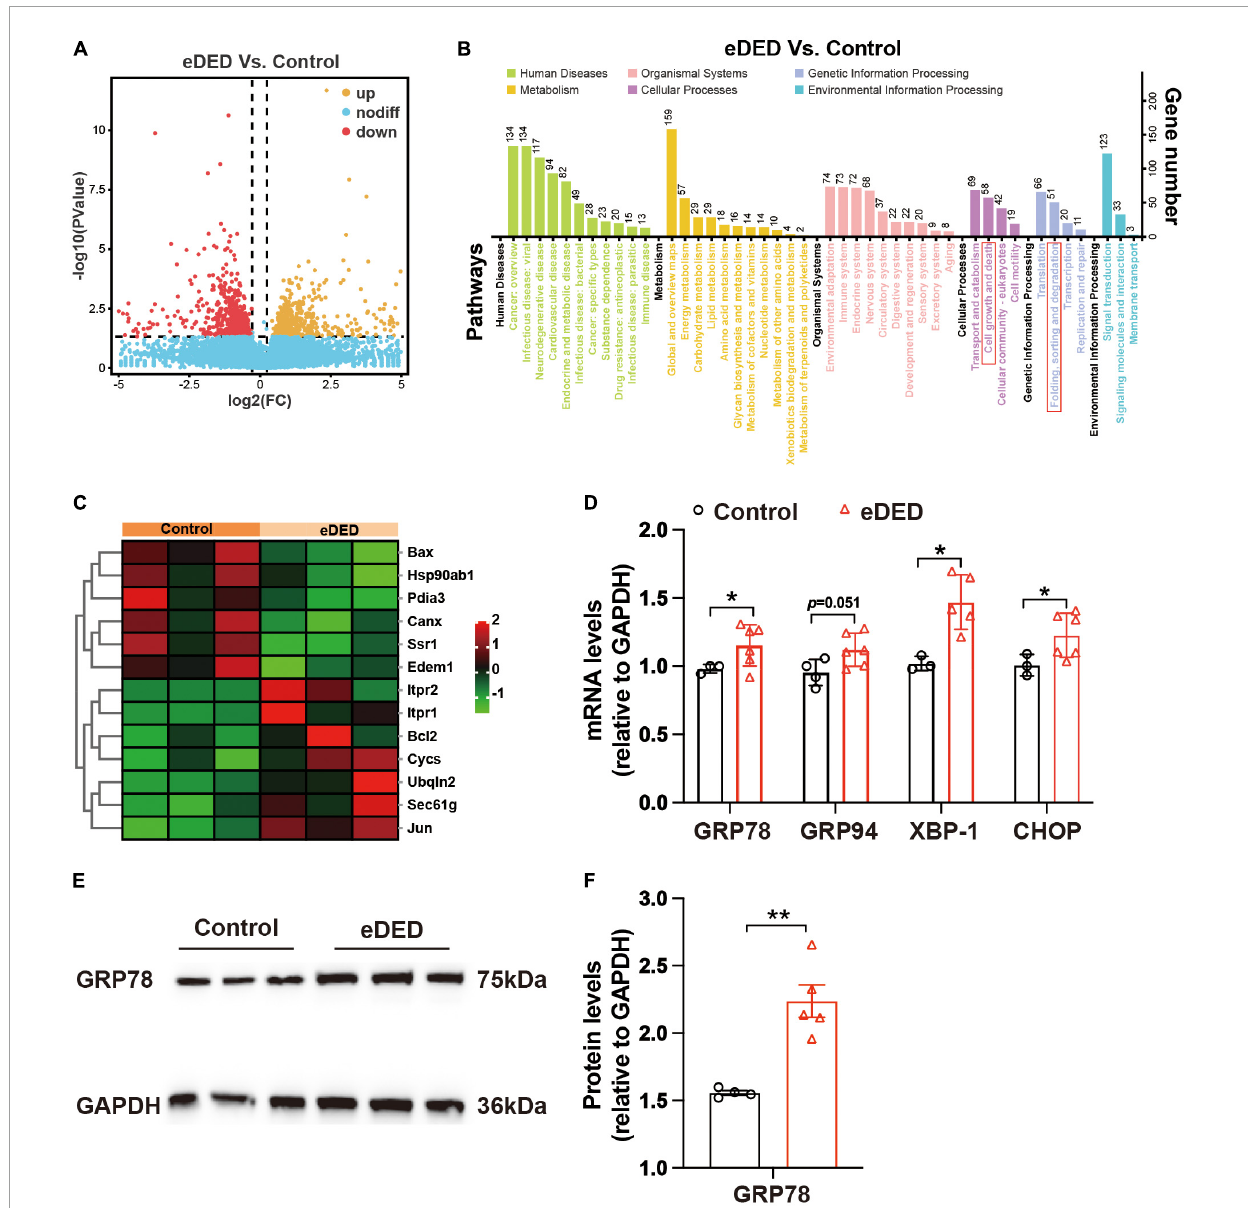
FIGURE4 Trigeminal ganglion (TG) corneal neuron RNA sequencing analysis. (A) Volcano plot showing the different genes between the control and eDED groups on day 14 ( n = 3 in each group). Yellow: upregulated genes, red: downregulated genes, blue: unchanged genes. (B) KEGG enrichment analysis in the control and eDED groups on day 14 ( n = 3 in each group). The X-axis represents the pathways, and the Y-axis represents the gene number. The cell growth and death pathways as well as folding, sorting, and degradation pathways are marked with red rectangles. (C) Heat map of differentially expressed genes of ERS and apoptosis on day 14. Red: upregulation; green: downregulation. RNA sequencing analysis with the parameters of P < 0.05 and absolute fold change ≥ 1.2 were considered differentially expressed genes/transcripts. (D) Quantification of ERS and apoptosis-related genes (GRP78, GRP94, XBP-1, and CHOP) expression levels in TG on day 14. The measured RNA expression levels were normalized to GAPDH. (E) Increased ERS-related protein GRP78 expression indicated by western blot in eDED TG on day 14. (F) The